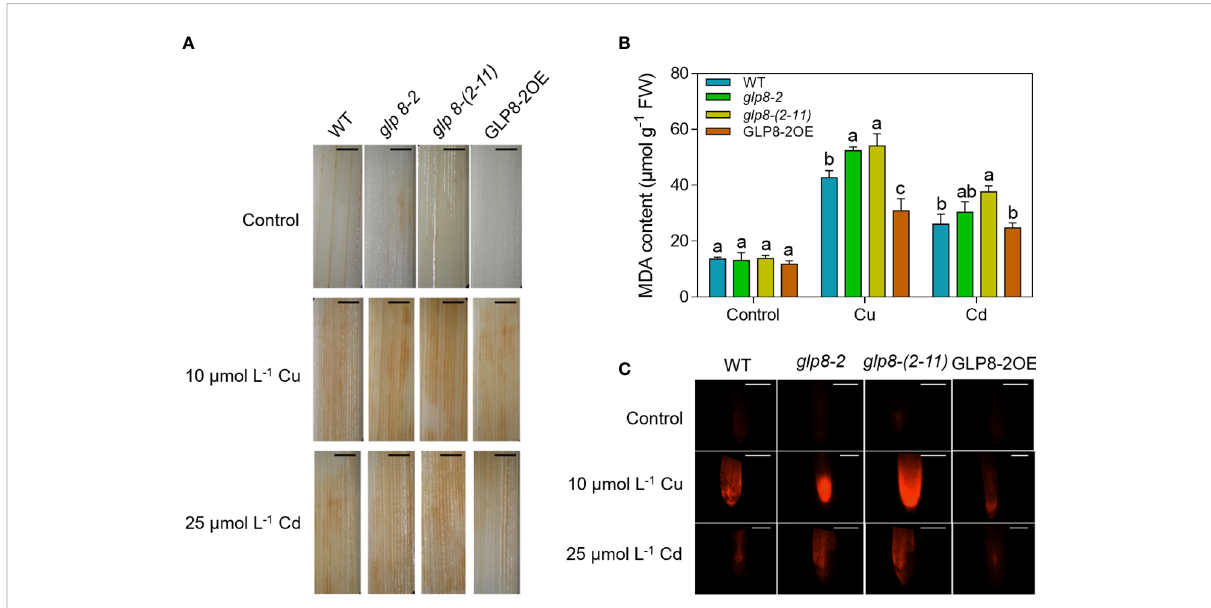
FIGURE 7 OsGLPs protect against heavy metal-induced oxidative stress. (A) Histochemical localisation of H 2 O 2 in leaves of two-week-old WT (wild type) and transgenic seedlings grown for 5 days under normal conditions, 10 m mol L − 1 CuSO 4 treatment, or 25 m mol L − 1 CdCl 2 treatment. The shade of brown represents the amount of H 2 O 2 . Scale bar = 2 mm. (B) MDA content of leaves of two-week-old WT and transgenic seedlings grown for 5 days under normal conditions, 10 m mol L − 1 CuSO 4 treatment, or 25 m mol L − 1 CdCl 2 treatment. Values are the mean ± SD; n = 3. Different letters indicate a difference of p ≤ 0.05 by the LSD test. (C) The integrity of the cell plasma membrane of rice roots of two-week-old WT and transgenic seedlings grown for 5 days under normal conditions, 10 m mol L − 1 CuSO 4 treatment, or 25 m mol L − 1 CdCl 2 treatment. Red represents the damage to the plasma membrane. The darker the red, the worse the integrity of the plasma membrane. Scale bar = 200 m m.